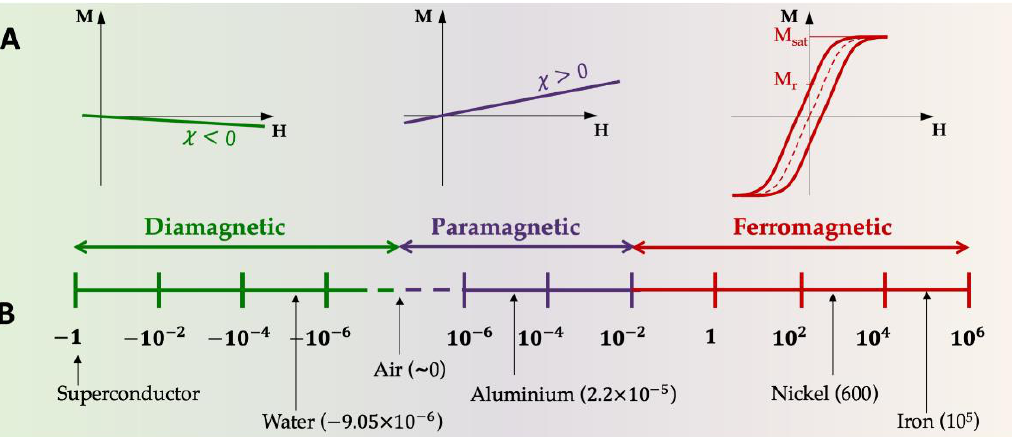
Figure 1. Magnetic properties of materials. ( A ) Magnetization curves (M-H) of diamagnetic, paramagnetic and ferromagnetic materials. The dotted line on the red curve corresponds to superparamagnetic behavior. M sat and M r refer to saturation and remanent magnetization, respectively. ( B ) Classification of materials according to their susceptibility value (volume susceptibility, SI units).